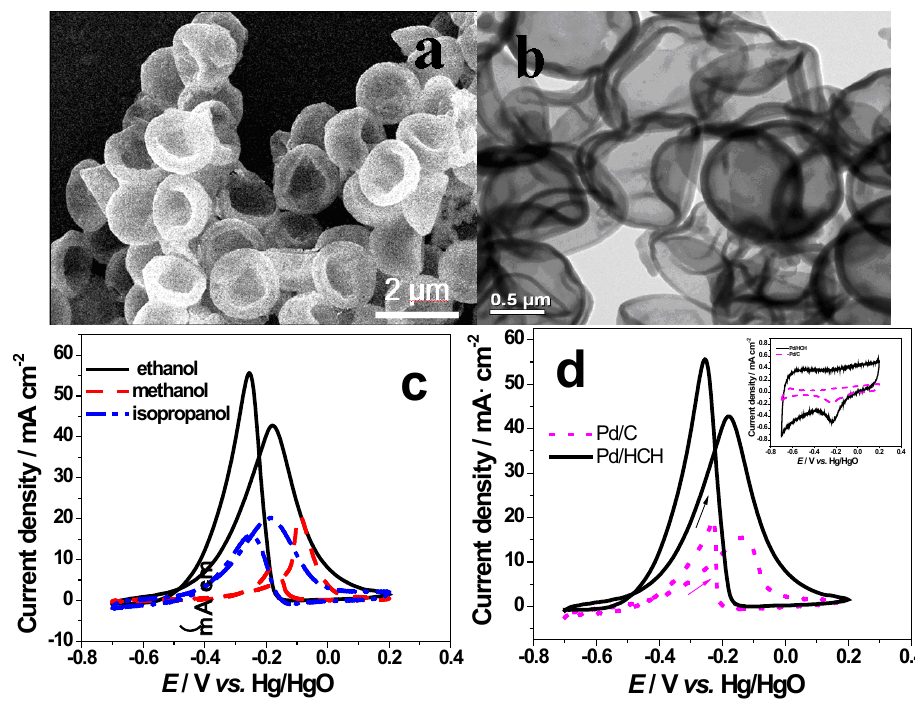
Figure 7. SEM microgram ( a ) and TEM image ( b ) of the HCHs with the mass ratio of PSs to glucose of 1:2 and the cyclic voltammograms of ( c ) different alcohol oxidation on Pd/HCH electrodes in 1.0 mol dm − 3 KOH/1.0 mol dm − 3 alcohol solution at 303 K, scan rate: 50 mV s − 1 and ( d ) ethanol oxidation on Pd/HCH and Pd/C electrodes in 1.0 mol dm − 3 KOH/1.0 mol dm − 3 ethanol solution at 303 K, scan rate: 50 mV s − 1 . The inset in Figure 7d is the cyclic voltammograms of Pd/HCH and Pd/C in 1.0 mol dm − 3 KOH solution at 303 K, scan rate: 50 mV s − 1 . Reproduced with permission from reference